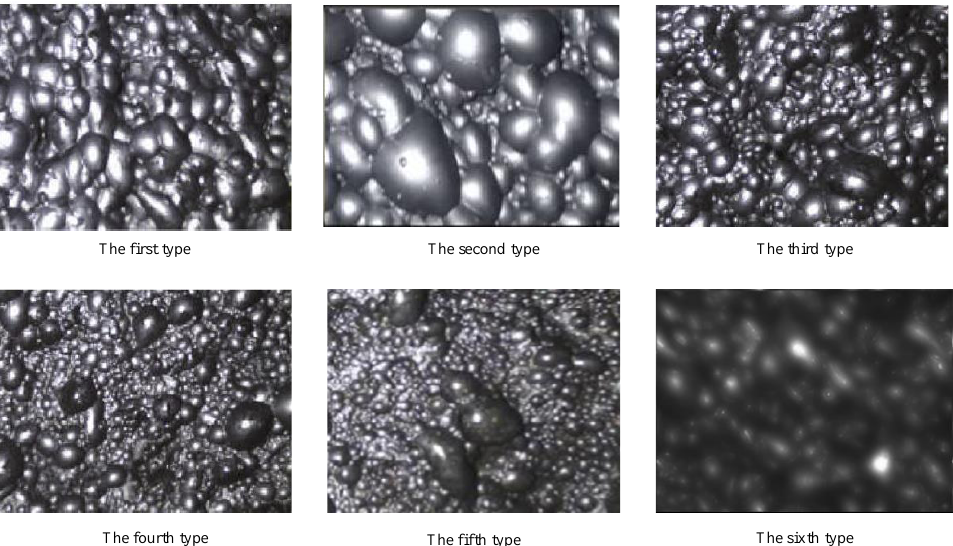
Figure 1. Foam images from six performance